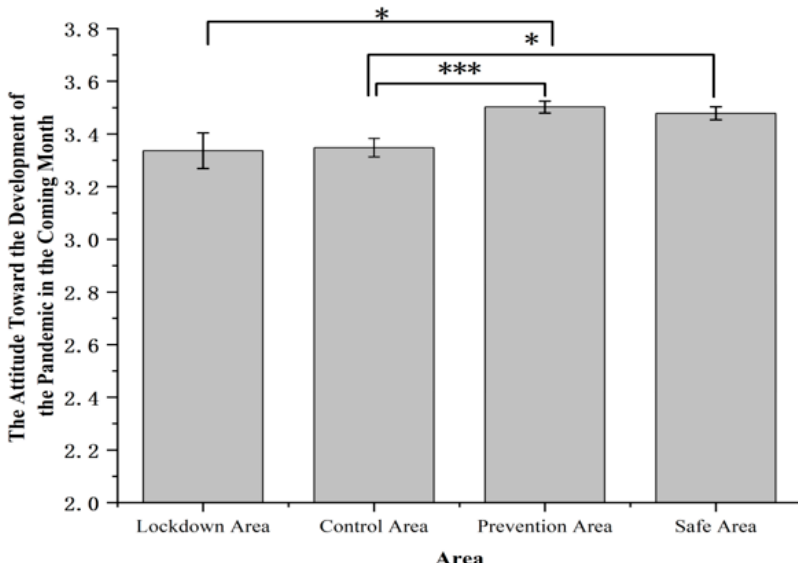
Figure 6. The attitude toward the development of the pandemic in the coming month. Note: The rating of attitudes toward the development of the pandemic in the coming month was measured on a 4-point scale (1 = much more severe, 2 = more severe, 3 = more relieve, 4 = much more relieve). Error bars represent standard errors. * p < 0.05, *** p < 0.001.